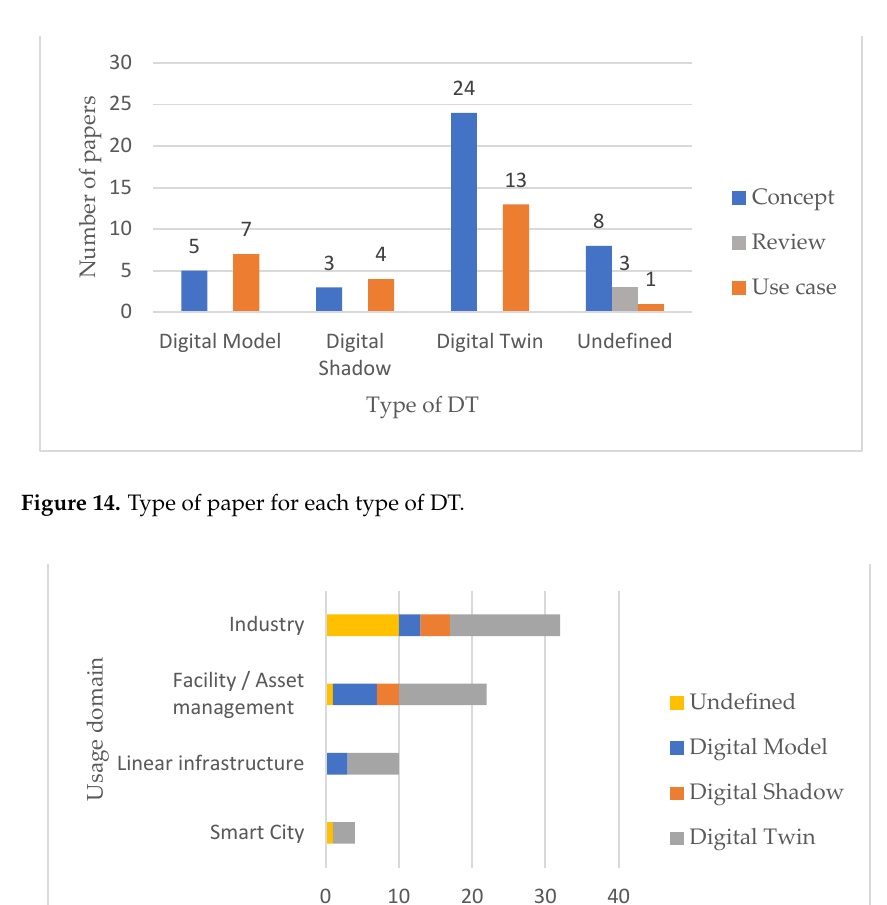
Figure 13. Number and type of DT by year.